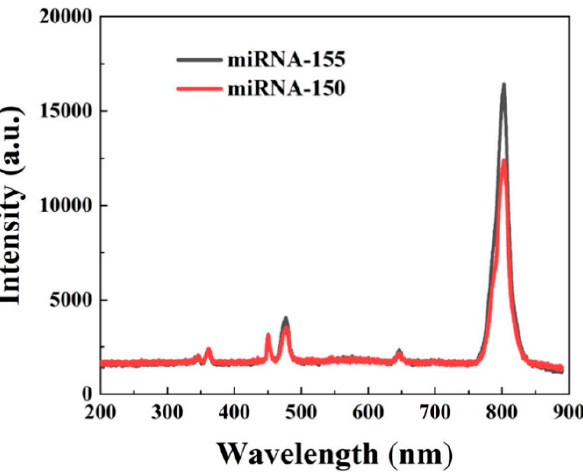
Figure 11. Fluorescence spectra of fluorescent probes connected to miRNA-155 and miRNA-150 under excitation at 980 nm.